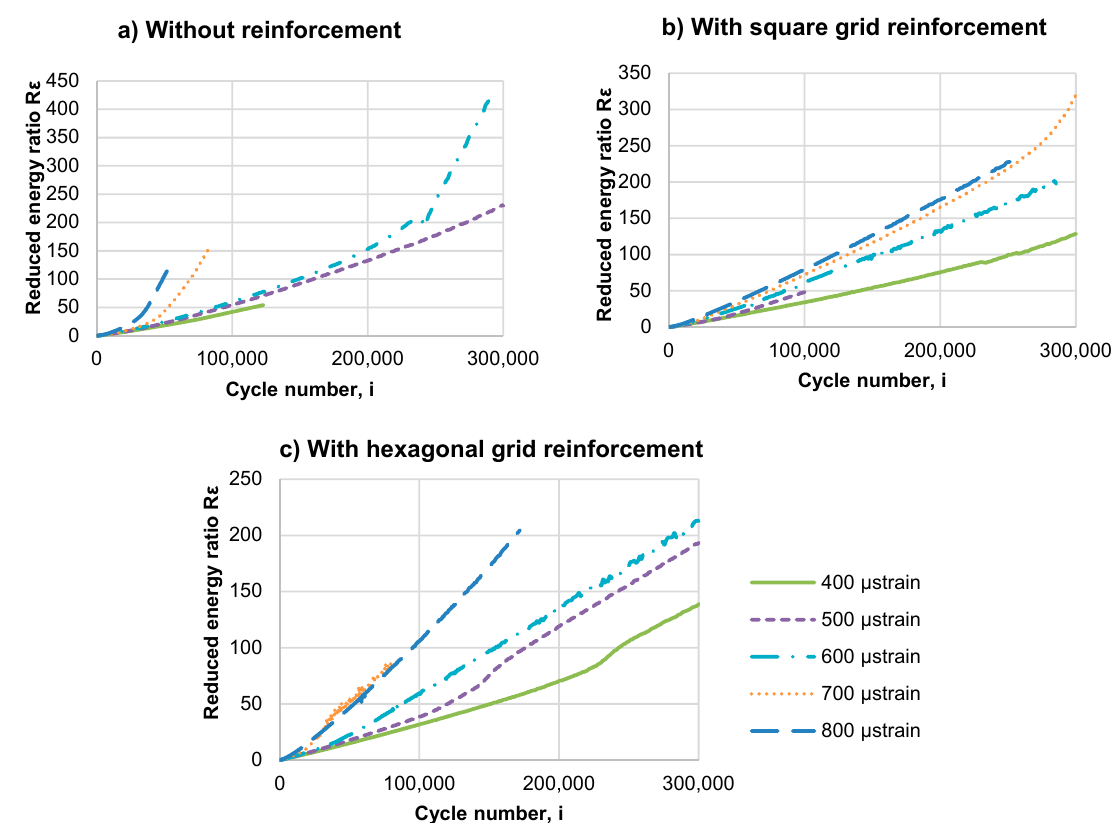
Figure 11. The change in the energy parameter R ε of double-layered asphalt concrete beams: ( a ) without reinforcement, ( b ) with square grid reinforcement and ( c ) with hexagonal grid reinforcement.